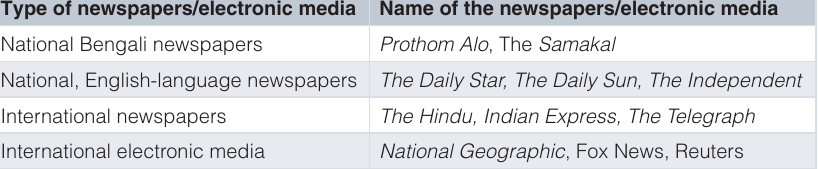
Table 1. National and international newspapers and electronic media used in the data